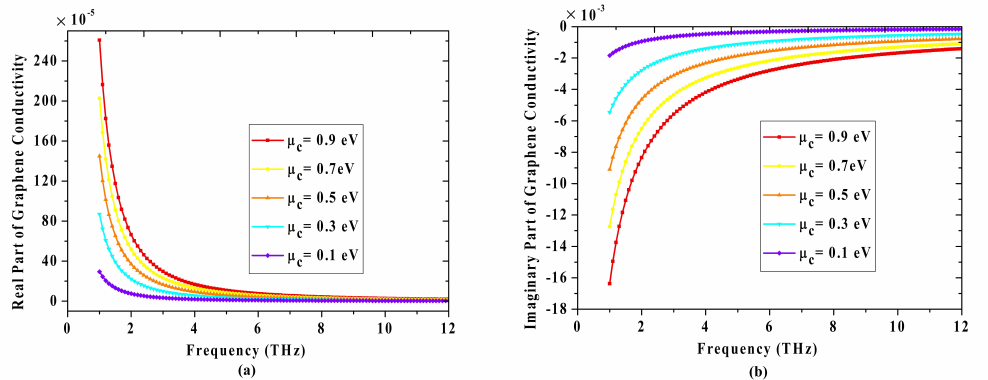
Figure 2. The ( a ) real part and ( b ) imaginary part of graphene conductivity with the change of the Fermi